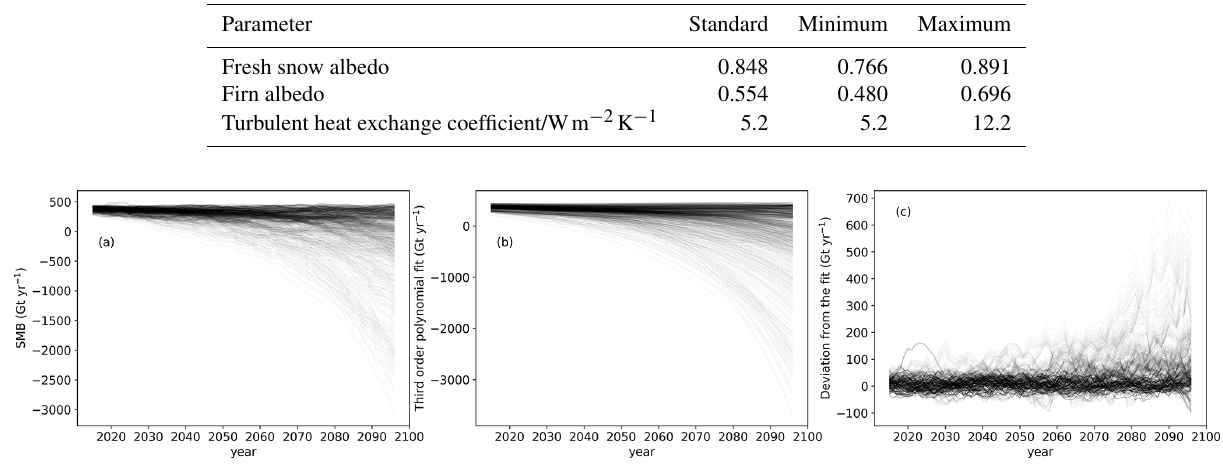
Figure C1. (a) Decadal running means of SMB for every parameter–scenario–ESM combination. (b) Fourth-degree polynomial fits of the curves in (a) . (c) Deviations of the curves in (a) from the fit in (b) .